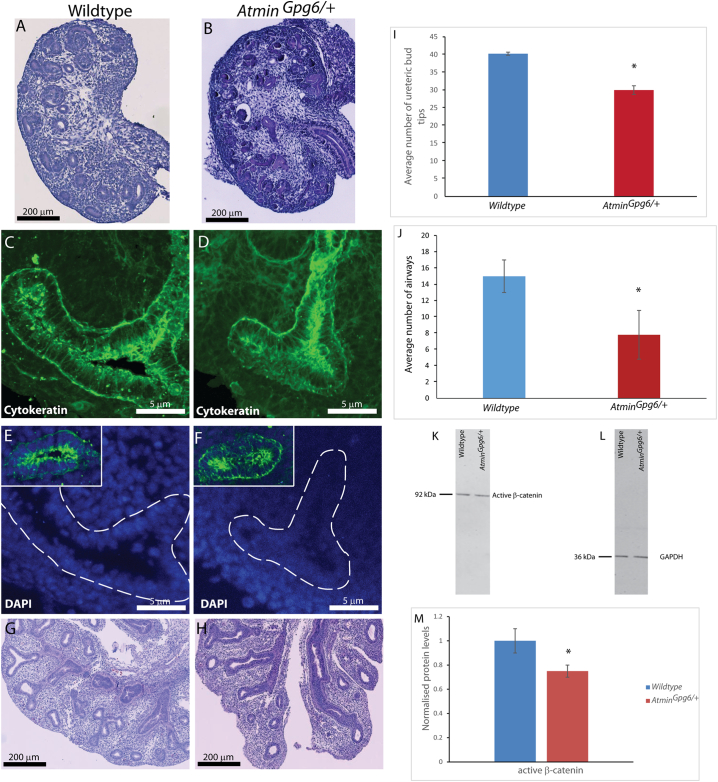
Cytoskeletal differences are detected in E13.5 AtminGpg6/+ embryos. AtminGpg6/+ kidneys (B) were smaller than wildtype (A), with a reduced number of ureteric bud tips (I). In z-stack images of wildtype (C, E) and AtminGpg6/+ (D, F) kidneys, epithelial cells appeared disorganised and were difficult to distinguish from the mesenchyme. AtminGpg6/+ lungs (H) were severely hypomorphic compared to age-matched wildtype lungs (G) and showed a reduction in the number of airways (J). Decreased active β-catenin expression was observed in AtminGpg6/+ kidneys compared to wildtype (K, L, M). Images are representative of at least six animals per group.